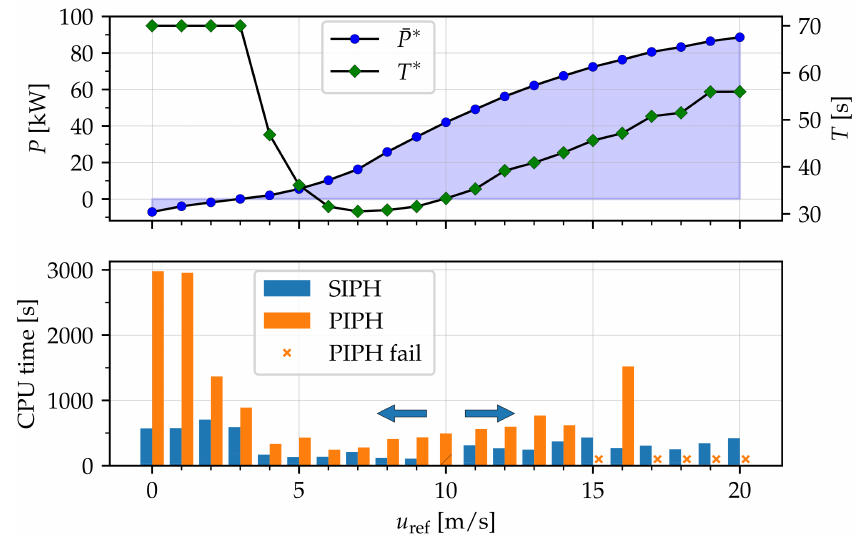
Figure 6. Average power output ¯ P ∗ and optimal time period T ∗ of a dual-aircraft AWE system ( top ) and CPU wall time for the PIPH and SIPH method ( bottom ) as a function of the reference wind speed u ref